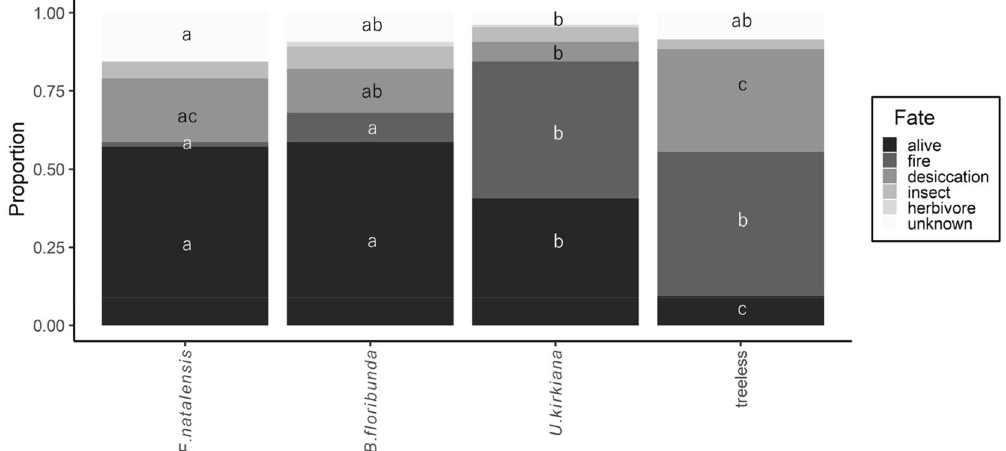
Figure 2. Fate of Syzygium guineense ssp. afromontanum transplants at the 4 microsites after 2.5 years. Seedling survival (n = 512) was measured from February 2012 to August 2014. All microsites were located in miombo woodlands. Different letters within each fate class indicate significant differences ( P < 0.05) based on Tukey’s post hoc